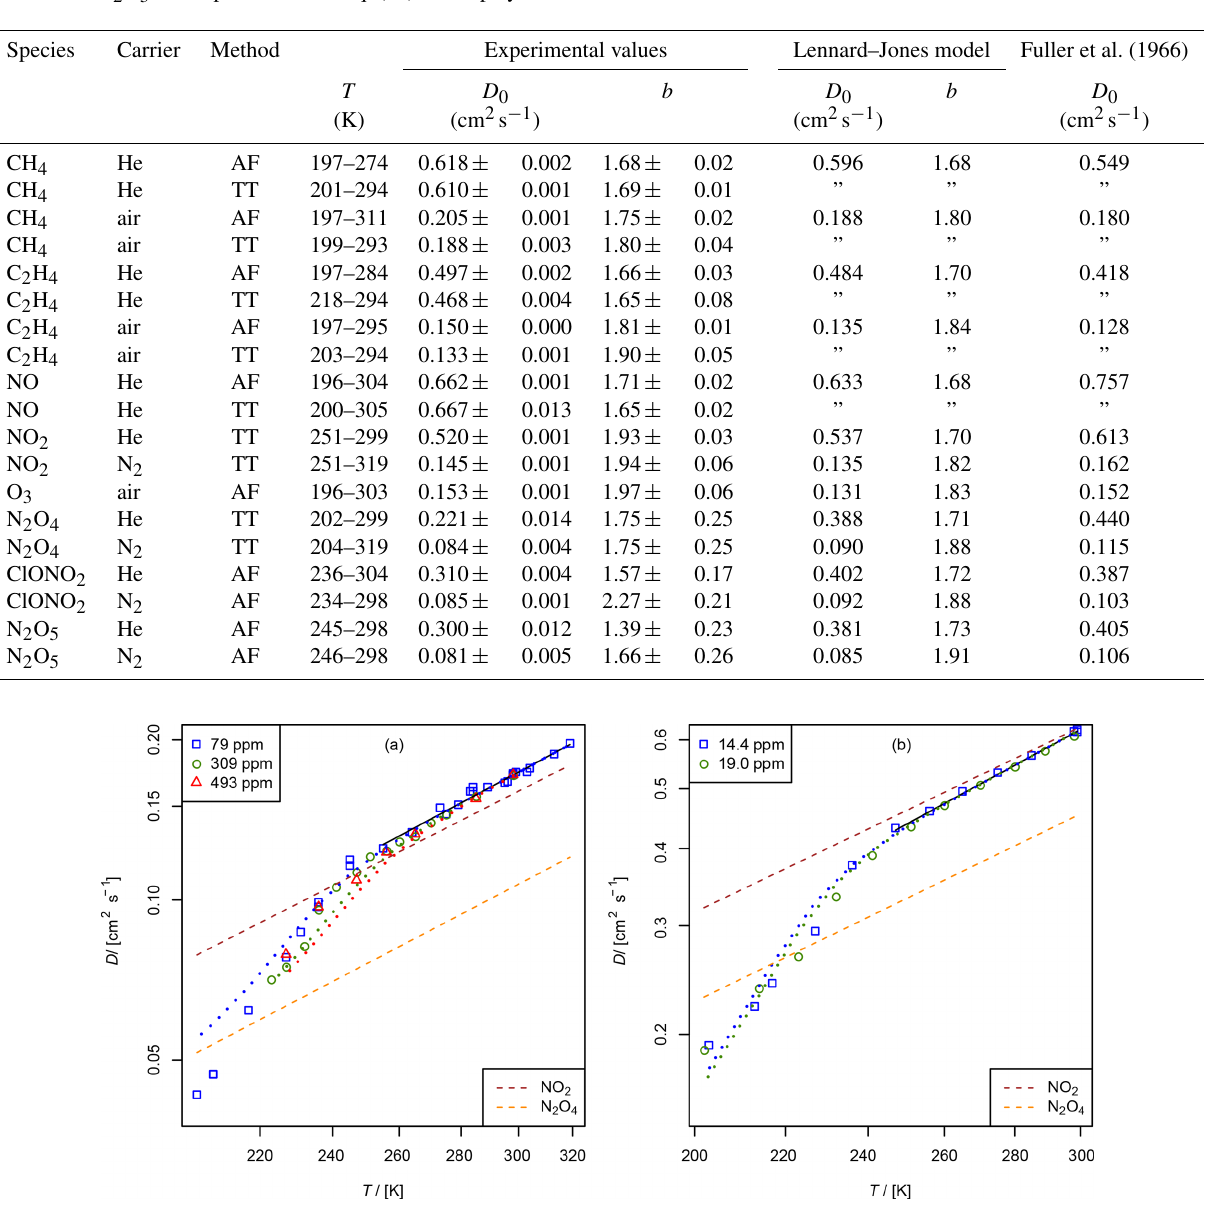
Table 3. Diffusion coefficient D 0 at standard temperature (273.15K) and pressure (101325Pa) and temperature coefficient b as results from the fit of Eq. (5) to the measured data. The errors listed are the errors obtained by the fit. Diffusion coefficients calculated by the Lennard– Jones and Fuller method are displayed for comparison. D 0 ( N 2 O 4 ) is estimated by the nonlinear regression of Eq. (23), arbitrarily setting b = 1 . 75. For N 2 O 5 the fit parameters of Eq. (15) are displayed.